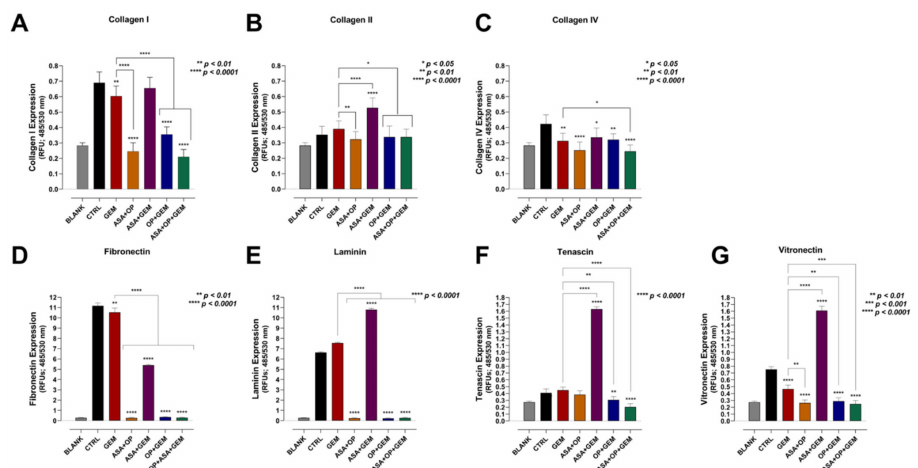
Figure 6. ASA, OP, GEM, and their combination alter the expression of adhesion markers in MiaPaCa- 2 cells. MiaPaCa-2 cells were pre-treated with ASA (0.7 mM), OP (3.5 mM), GEM (0.285 µ M), or their combination for 7 days. Cells were collected, resuspended, and adhered to coated substrates to capture adherent cells. Adherent cells were lysed and dyed, allowed to incubate, and read with a fluorescence plate reader. Graphs show expression of ( A ) collagen I, ( B ) collagen II, ( C ) collagen IV, ( D ) fibronectin, ( E ) laminin, ( F ) tenascin, and ( G ) vitronectin as relative fluorescent units (RFUs) (ex 450 nm: em 530 nm). Data are presented as the mean ± SEM of 3 independent experiments performed in triplicates. Significance is shown compared to the CTRL unless otherwise indicated using the one-way ANOVA Fisher test comparisons with 95% confidence with indicated asterisks for statistical significance. Abbreviations: ASA, aspirin; OP, oseltamivir phosphate; GEM, gemcitabine; RFU, relative fluorescent unit; SEM, standard error of the mean; CTRL, control.